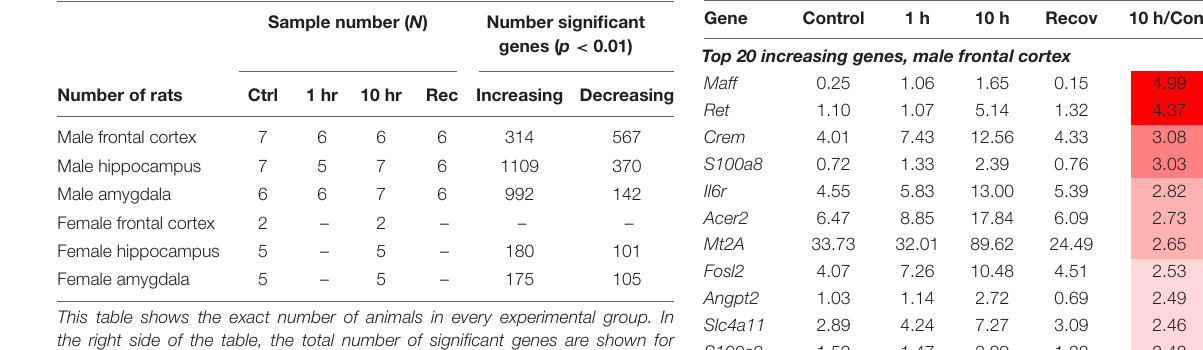
TABLE 1 | Summary table of RNA-Seq data from six experiments. TABLE 2 | Male frontal cortex top 20 increasing and decreasing